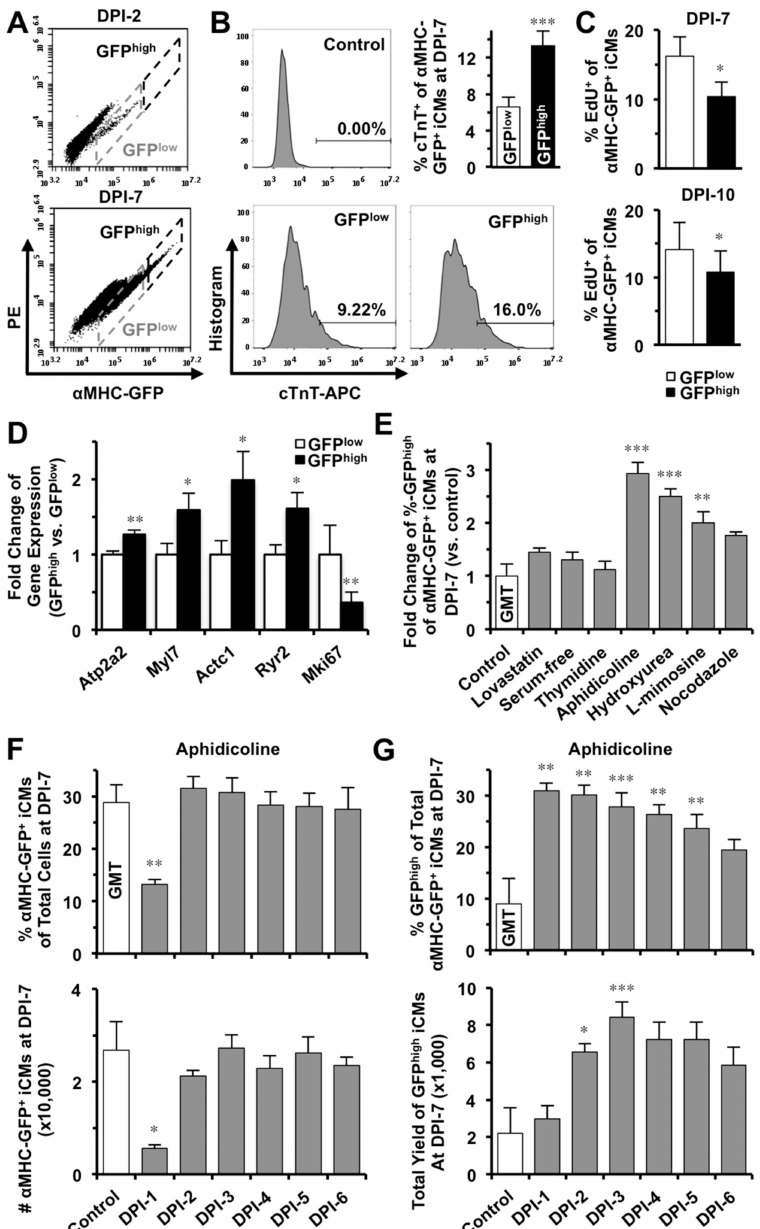
Figure 3. S-phase synchronization accelerates the early progression of reprogramming and increases the yield of GFP high iCMs. ( A ) Reprogrammed iCMs were classified into GFP low and GFP high populations. ( B ) GFP high iCMs contain cardiac troponin T + cells significantly more than GFP low iCMs ( n = 5, p = 0.0005) at DPI-7. ( C ) Significantly less GFP high iCMs were stained positive for EdU than GFP low cells at DPI-7 ( n = 3) and DPI-10 ( n = 6). ( D ) Comparisons of gene expression in GFP low and GFP high iCMs at DPI-7 ( n = 6). ( E ) Only synchronization of S-phase ( n = 6), but not of other-phases ( n = 3), at DPI-1 significantly increased GFP high population of GMT-iCMs at DPI-7. ( F ) The effect of S-phase synchronization by aphidicolin ( n = 3) from DPI-1 to DPI-6 on the percentage and absolute number of GMT-iCMs. ( G ) The effect of aphidicolin-synchronization ( n = 4) from DPI-1 to DPI-6 on the percentage and absolute number yield of GFP high iCMs. * p < 0.05; ** p < 0.01, *** p < 0.001 vs.